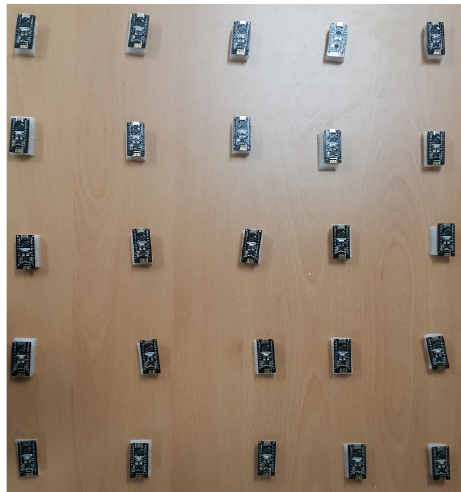
Figure 5. The 25-node setup.